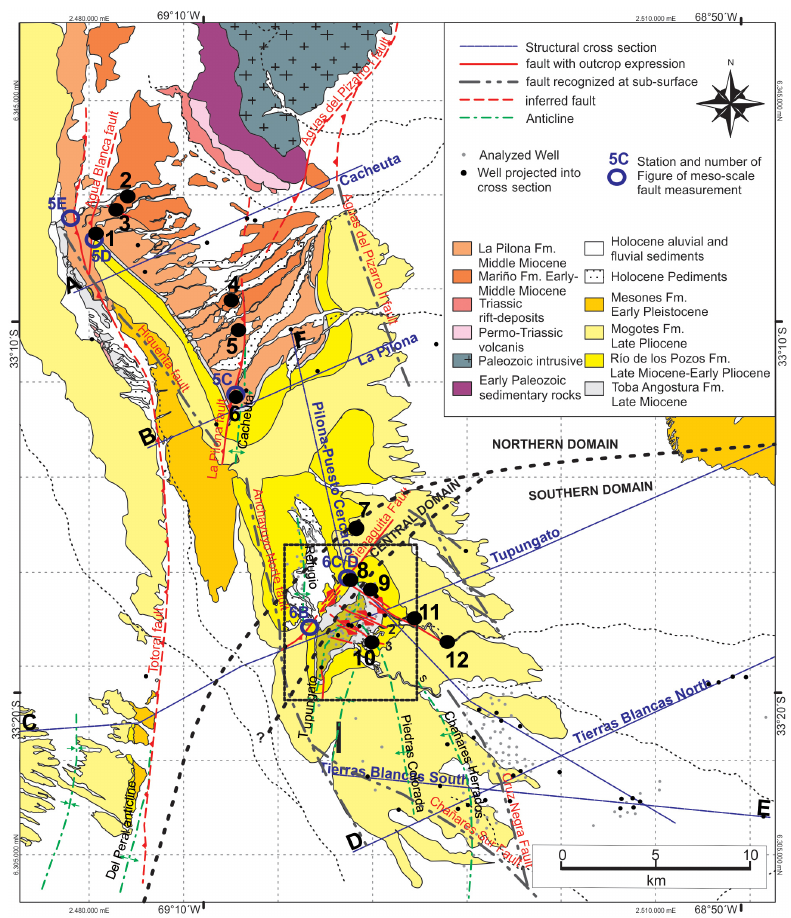
Figure 4. Geological map of the western axis of the Cuyo Basin, with the development of the Cacheuta sub-basin at subsurface. See location in Fig. 2. The area is divided into three structural/kinematic domains: northern, central and southern. Blue open circles are locations of kinematic measurements of major and second-order faults (Figs. 5 and 6). Black dots with numbers correspond to locations of mesoscopic fault-slip measurement station for the dynamic analysis. Box corresponds to Fig. 7. Blue lines indicate traces of cross sections. Names in red and black correspond to main faults and folds of the western axis,